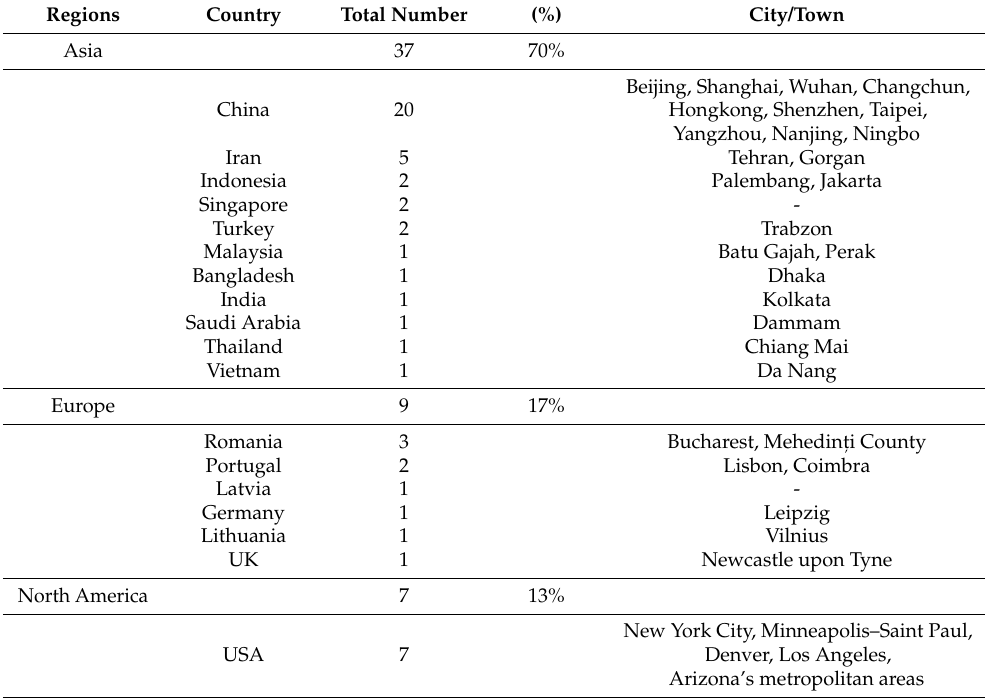
Table 3. The geographical distribution of the case study